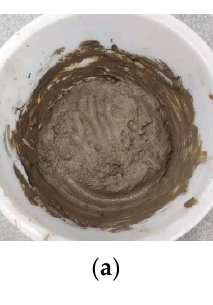
Figure 5. Moisture content variation of the solidified soil with curing time.